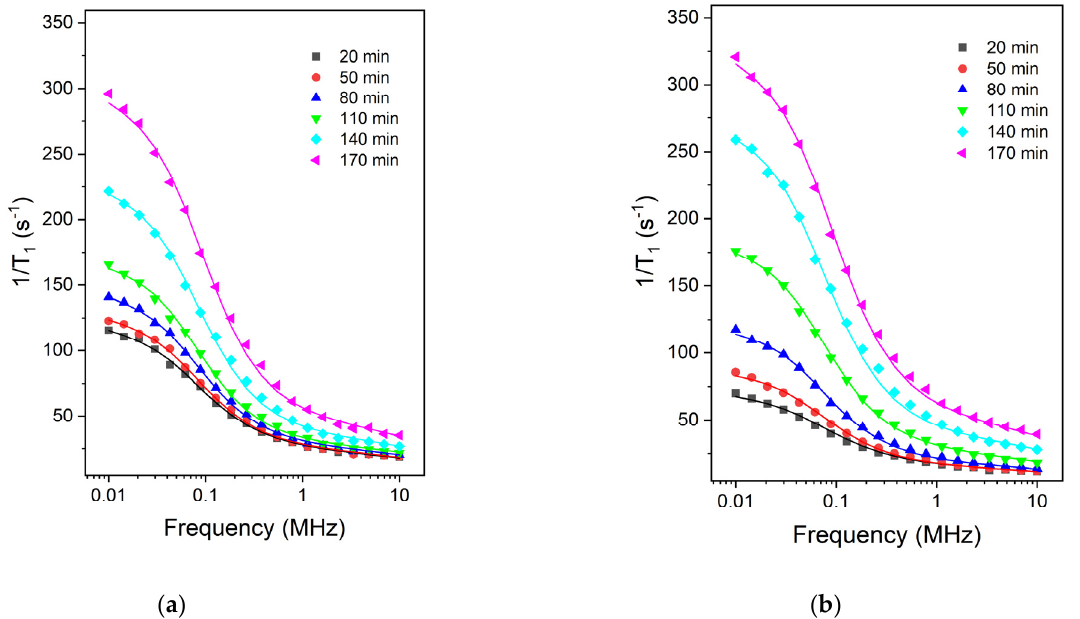
Figure 3. Relaxation dispersion curves recorded for the two samples during the early hydration: ( a ) the simple cement paste CP; ( b ) the cement paste prepared with 2% accelerator (CP + 2% Ca(NO 3 ) 2 ). The hydration times are indicated in the legend. The lines represent the best fits obtained with the 3-Tau